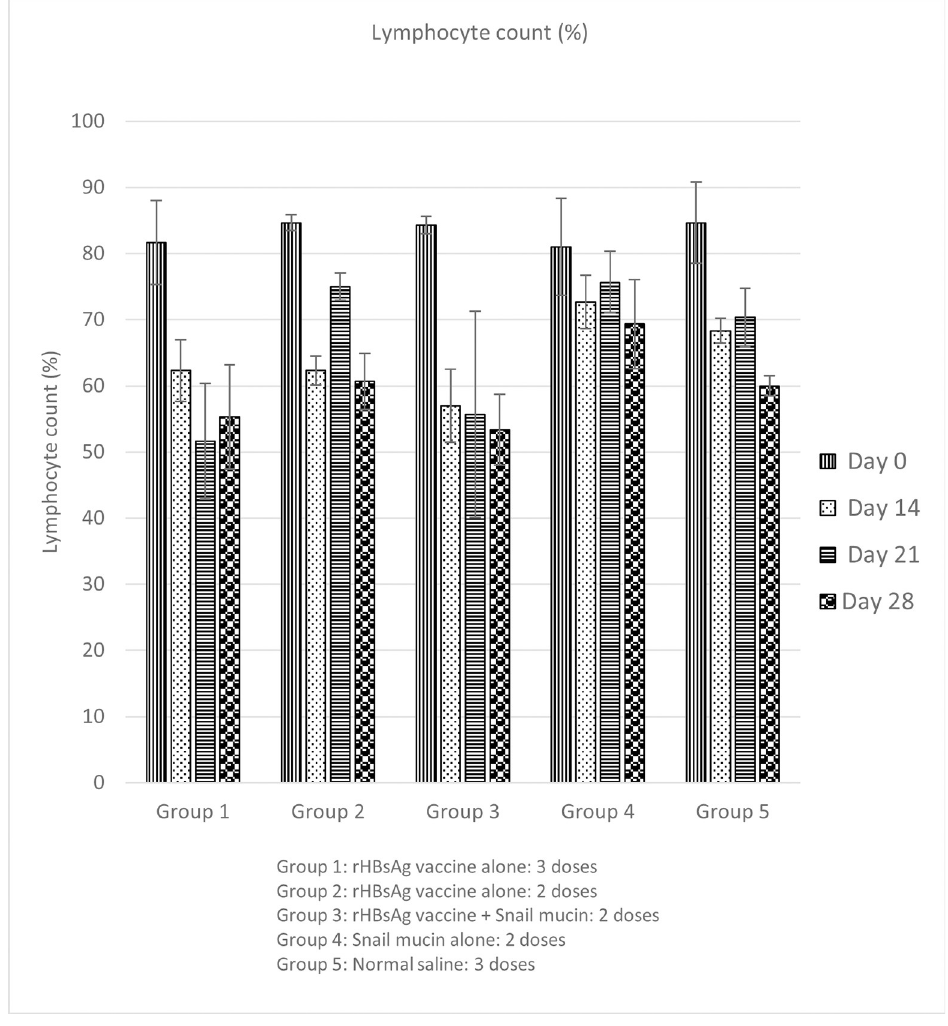
Fig 3. Effect of snail mucin-adjuvanted rHBsAg vaccine on lymphocyte count of experimental mice. Results are expressed as mean ± SD (n = 5) with a confidence interval of 0.05.